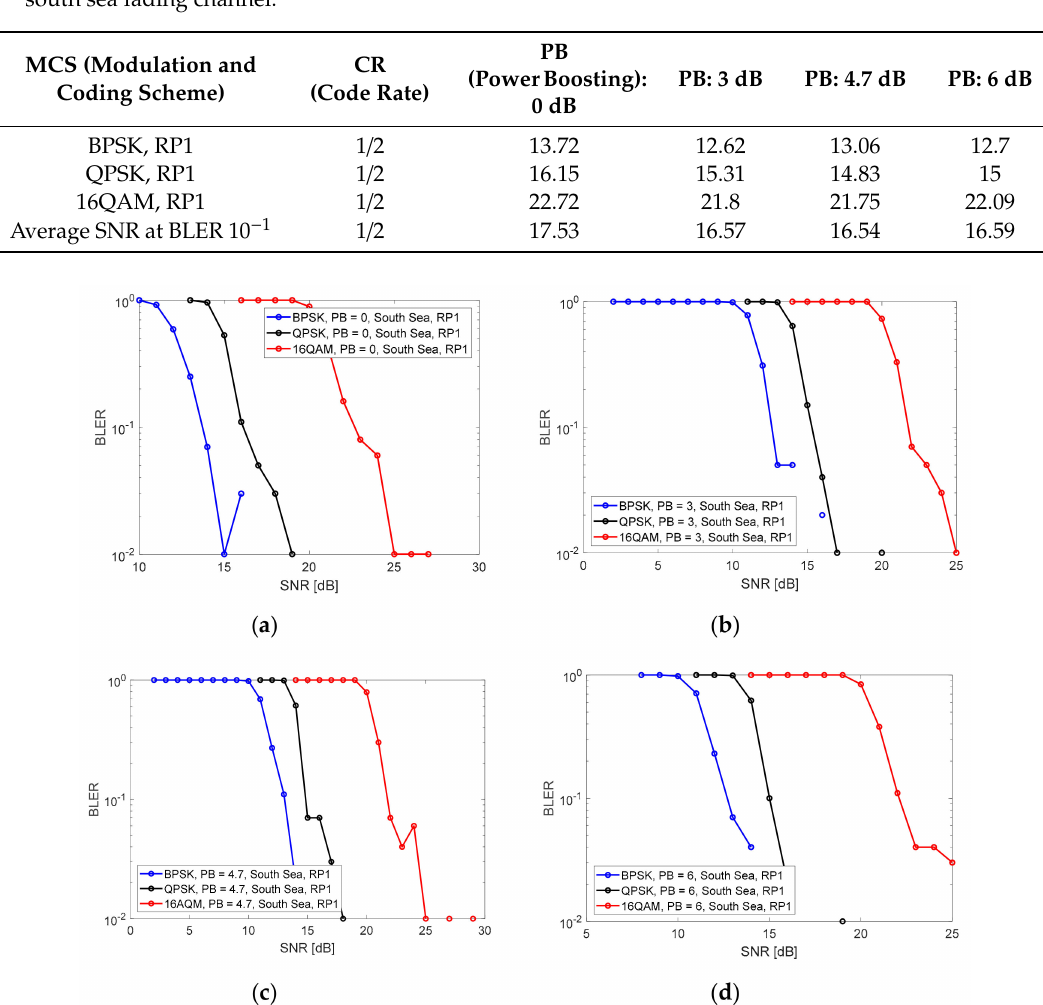
Table 3. Signal-to-noise ratio (SNR) comparison of MCS levels at 10 − 1 block error rate (BLER) on a south sea fading channel.